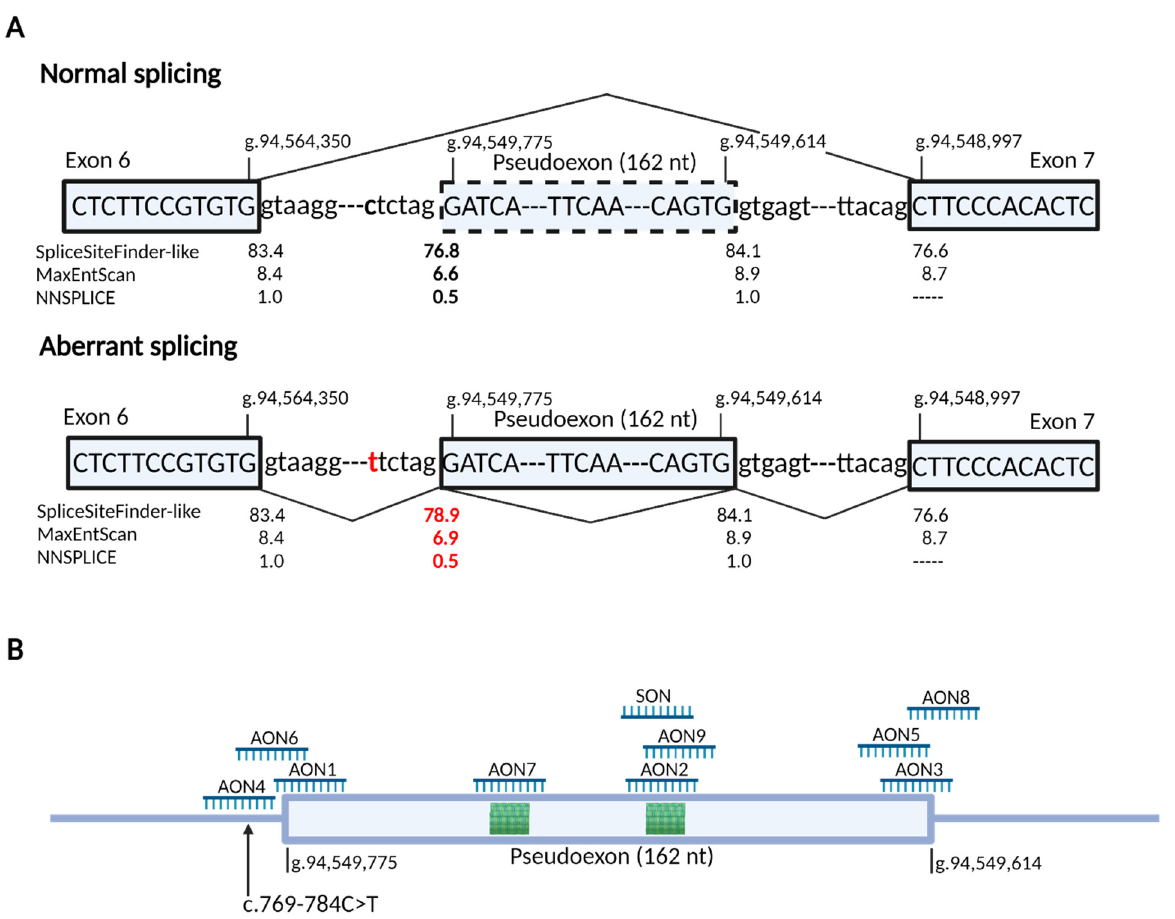
Figure 1. In silico characterization of the effect caused by the deep-intronic c.769-784C>T variant and schematic representation of the position of AONs. ( A ) The diagram represents boundaries of the 162-nt pseudoexon (PE) and the neighboring exons 6 and 7. The location of the c.769-784C>T variant is indicated in red. The lines illustrate the normal splicing using canonical spice sites and aberrant splicing using the cryptic splice sites due to the deep-intronic c.769-784C>T variant. The predicted values of splice site strength were acquired from the Alamut software. The C to T substitution strengthens the splice acceptor site slightly which is captured in red. ( B ) Positions of the AONs and SON targeting three distinctive sites of the PE; AON1, -4, and -6 target the cryptic splice acceptor site, AON3, -5, and -8 target the cryptic splice donor site, and AON2, -7, and -9 and SON target the predicted high score ESE motifs illustrated in green.